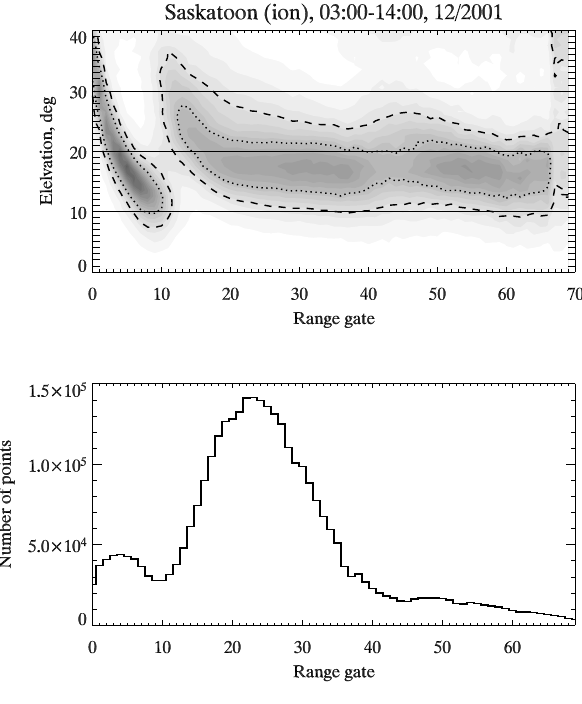
Fig. 10. Normalised elevation histograms at each range gate for ex- perimental data from Saskatoon, 03:00–14:00UT, 1–31 December 2001 (top panel). Dashed and dotted lines correspond to 0.025 and 0.05 probability, respectively. The bottom panel shows the num- ber of experimental points used for each range gate (normalisation